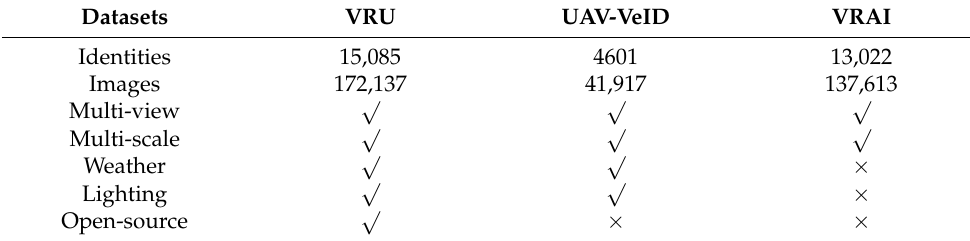
Table 1. Comparison of